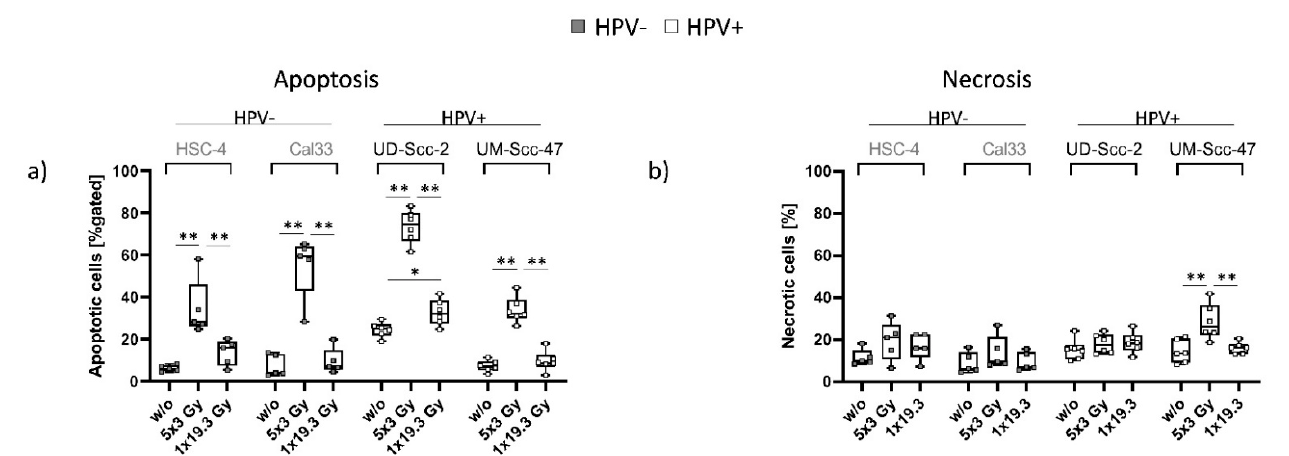
Figure 1. Cell death forms on day 7 for the two HPV-negative cell lines (HSC-4 and CAL33; grey dots) and the two HPV- positive cell lines (UD-Scc-2 and UM-Scc-47; white dots). The graphs show the percentage of early and late apoptotic ( a ) and necrotic cells ( b ) in the total cell count for all three treatment conditions, untreated ( w / o ), 5x3.0Gy and 1x19.3Gy n hpv − = 5; n hpv+ = 6 biological independent experiments. Graphs show median + min to max, and a two-sided Mann–Whitney U test was performed for comparisons of treatments within one cell line: * p < 0.05, ** p < 0.01.